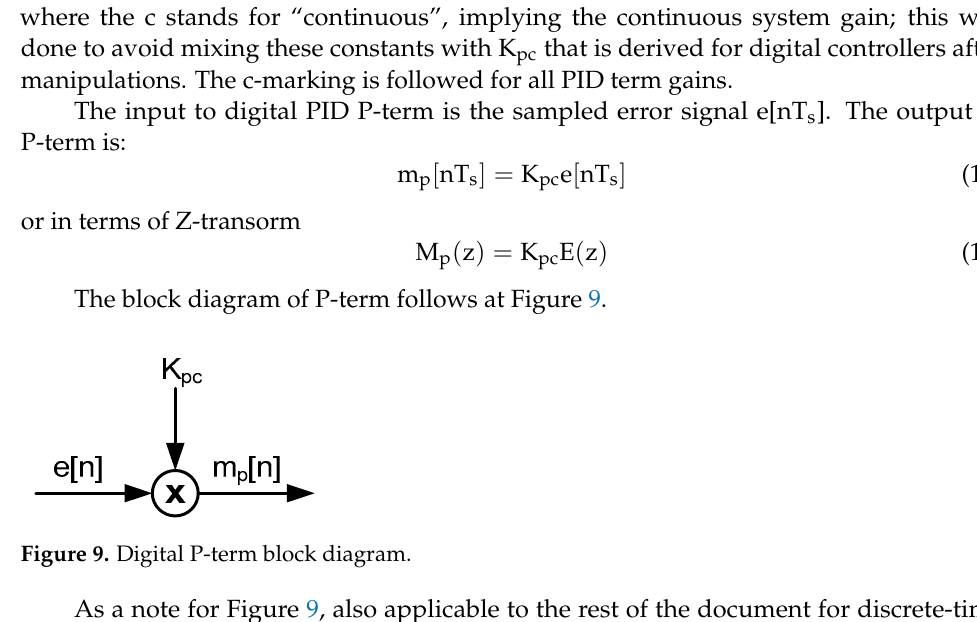
Figure 8 . Analog PID.